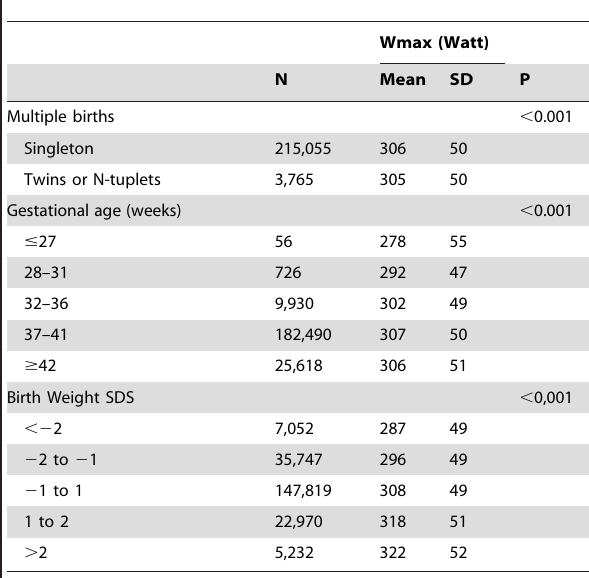
Table 4. Maximal exercise capacity by perinatal characteristics (univariate analysis).